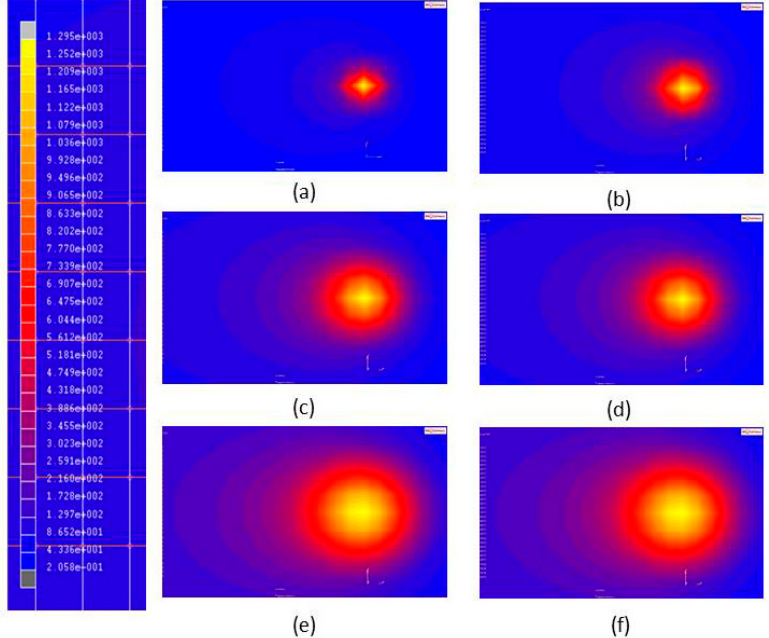
Figure 15. Temperature distributions induced by different laser spot sizes during single-track laser heat treatment. ( a ) AISI 1045, R i = 2 mm; ( b ) AISI 4140, R i = 2 mm; ( c ) AISI 1045, R i = 3 mm; ( d ) AISI 4140, R i = 3 mm; ( e ) AISI 1045, R i = 4 mm; and ( f ) AISI 4140, R i = 4